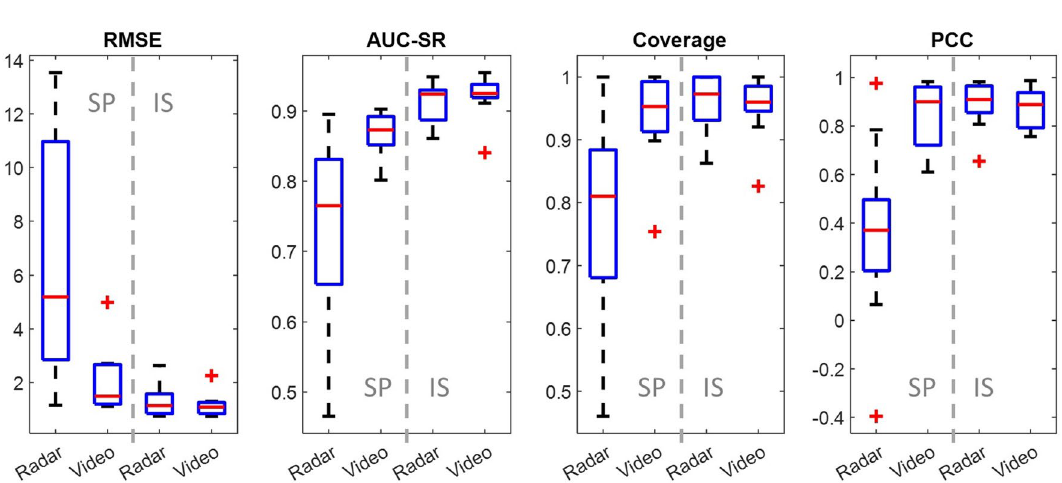
Figure 8. The Bland–Altman plots of the dataset for cross-comparison. SP: results of the spectral magnitude estimation method. IS: results of the image segmentation estimation method. Gold standard: a contact-based ECG device. ± 1.96 sd: the standard deviation of 95% prediction interval. d: the mean of the differences of the data w.r.t the time trace.